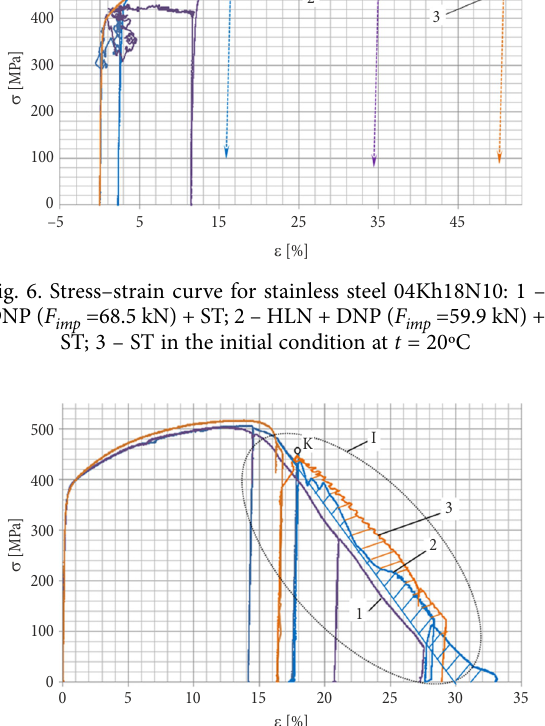
Fig. 7. Curves of macrocrack growth in specimens from stainless steel 04Kh18N10 with openings: 1 – ST, 2 – ST + DNP ( F imp =7.4 kN); 3 – ST + DNP ( F imp =12.7 kN) with the application of colloid